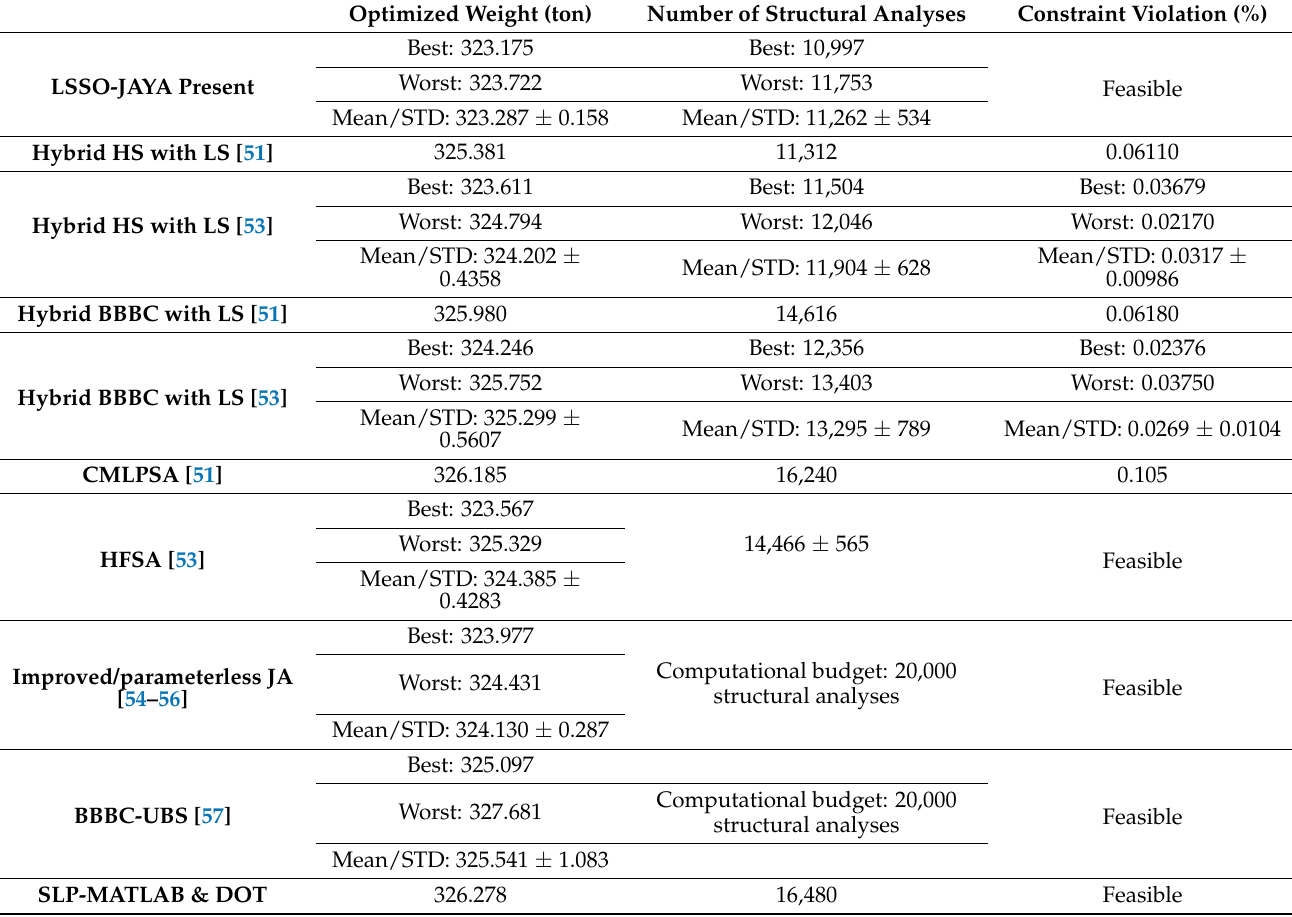
Table 6. Optimization results obtained for the 3586-bar tower design example. Optimized Weight (ton) Number of Structural Analyses Constraint Violation